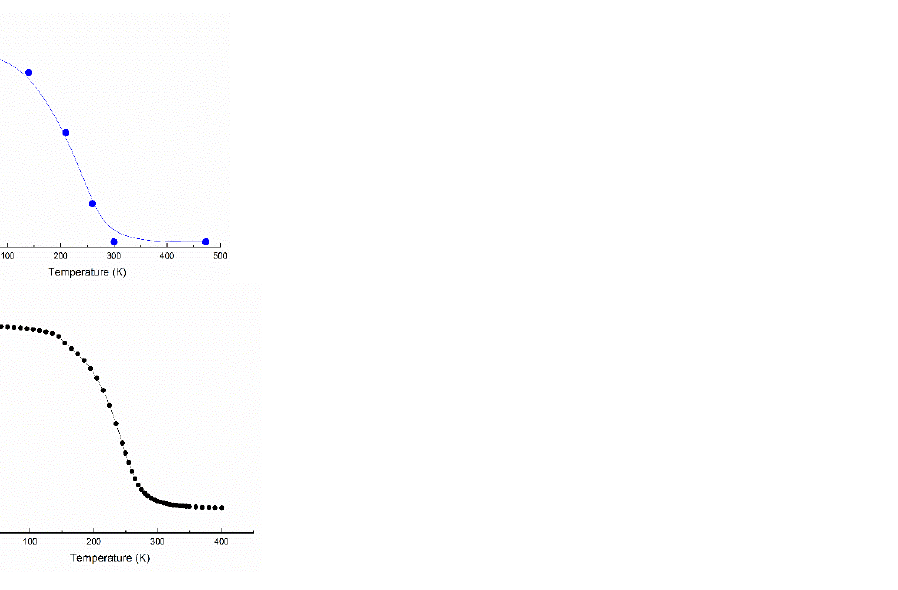
Figure 9. ( top ): B hf vs. T for Fe 3 Pt, as resulted from the fitting of Figure 8 spectra; ( bottom ): magnetization variation with temperature M(T) recorded using VSM.